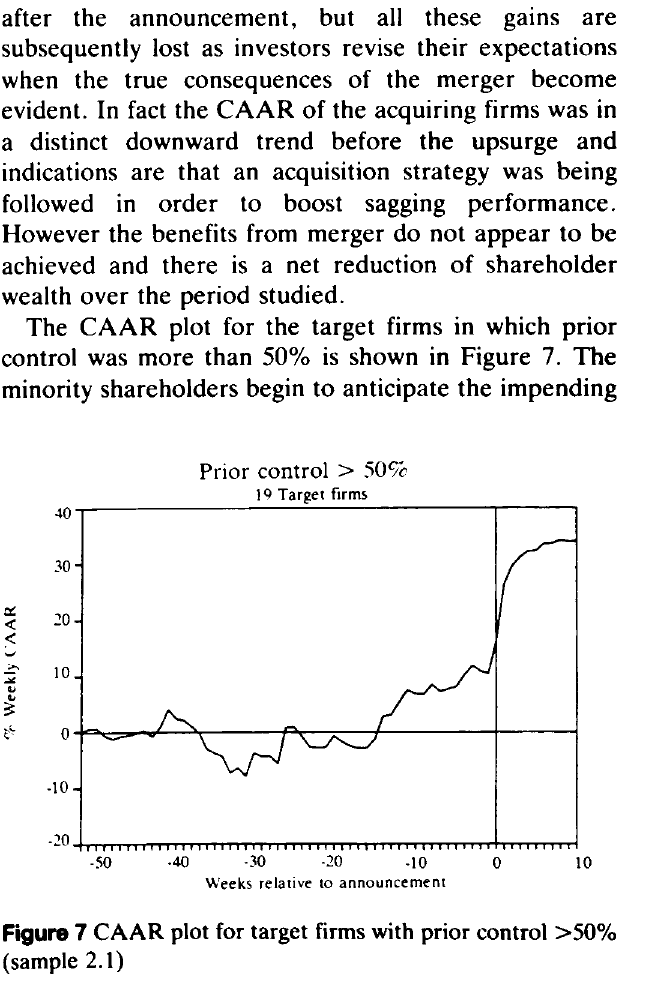
Figure 7 CAAR plot for target firms with prior control >50% (sample